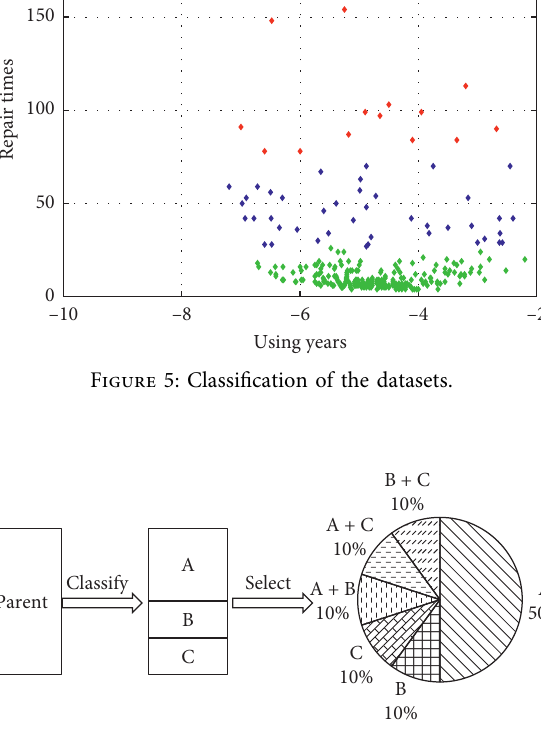
Figure 6: Population selection